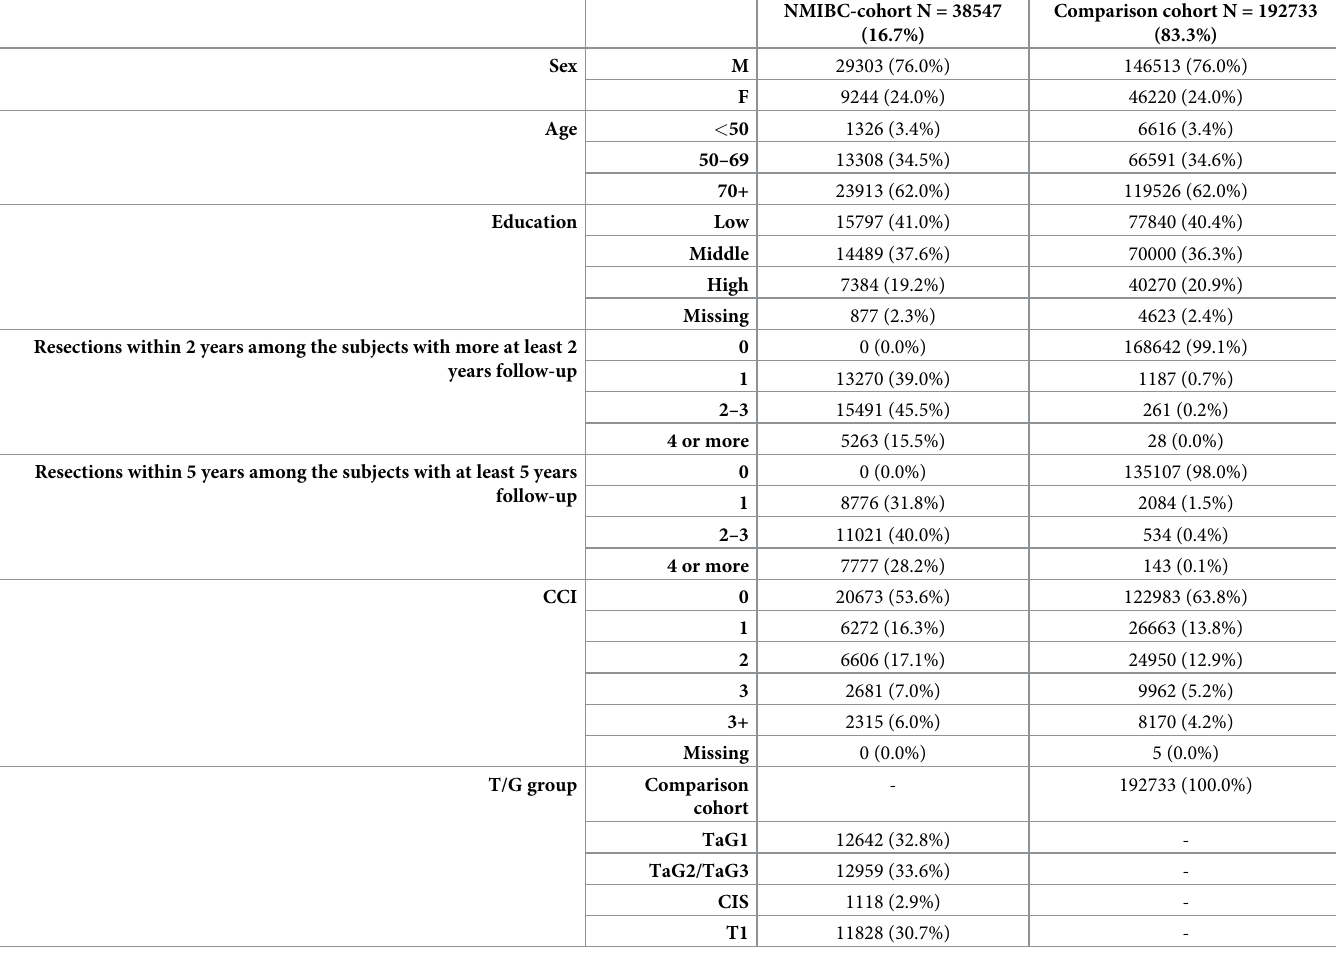
Table 1. Baseline characteristics and the number of transurethral procedures during 2 and 5 years of follow-up for the cohort of non-muscle invasive bladder cancer (NMIBC) patients and their matched comparison